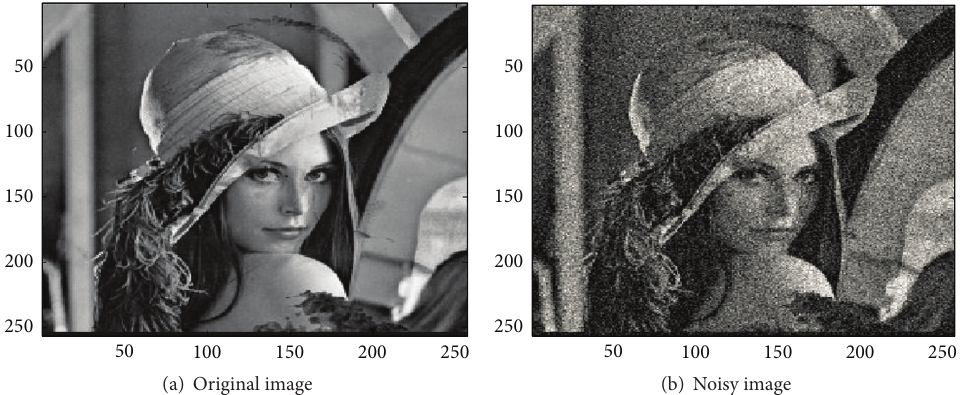
Figure 2: Gray Lean image and its contaminated version by Gaussian white noise.